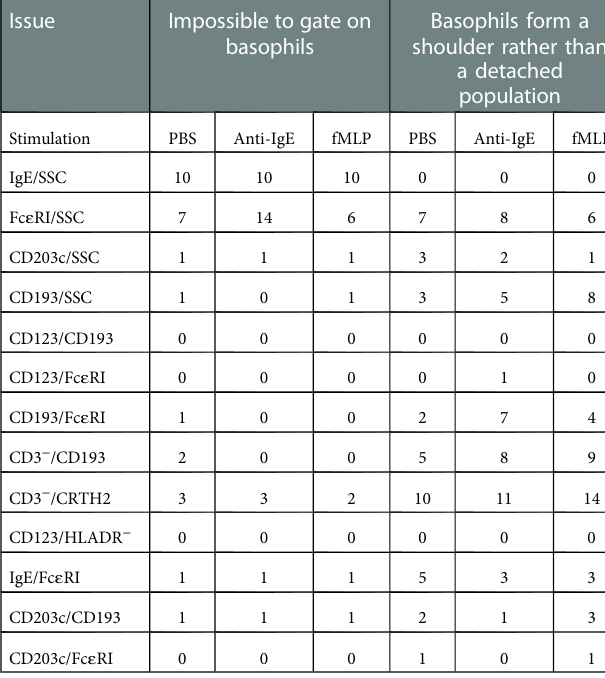
TABLE 2 Problematic basophil identi fi cation.